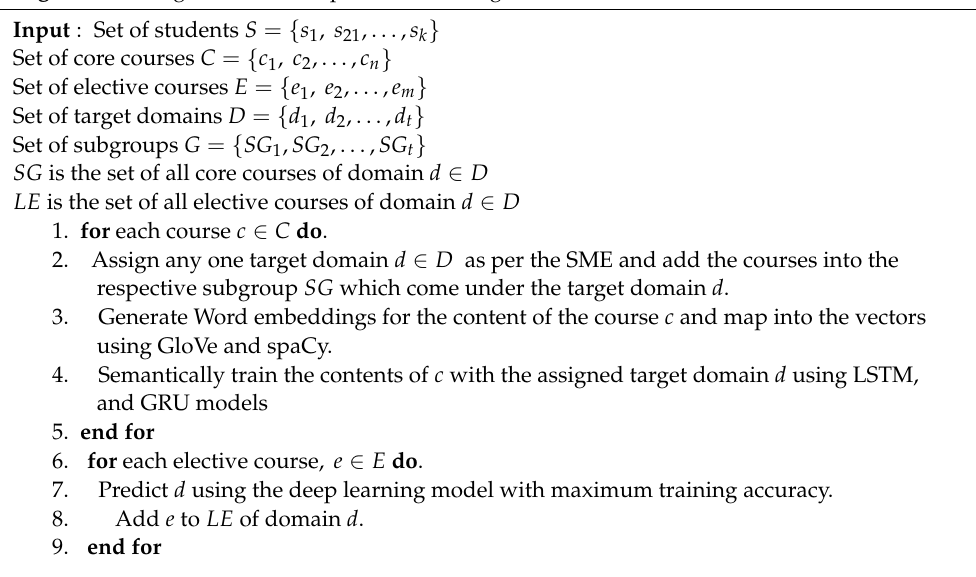
Algorithm 1: Algorithm for the prediction of target